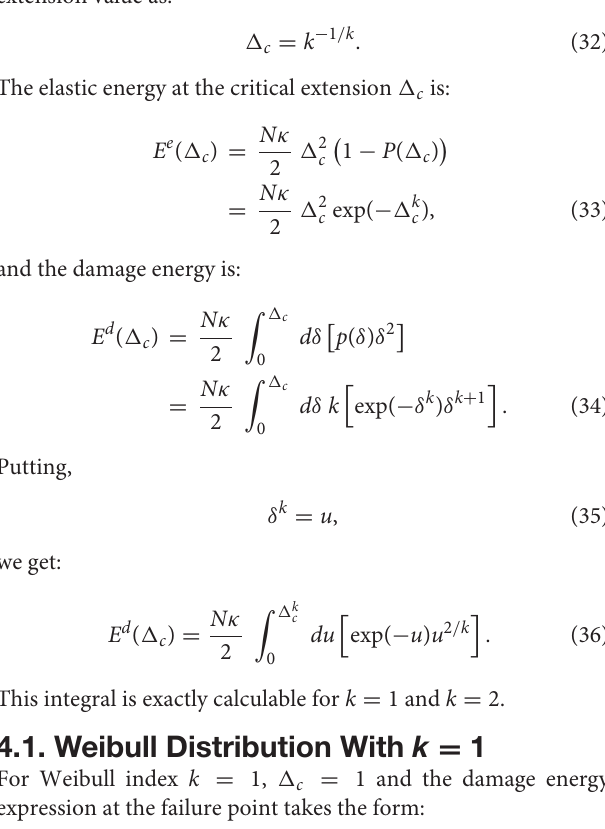
FIGURE 5 | Damage energy and elastic energy vs. extension 1 (up to the failure point 1 c ) for Weibull distribution of thresholds with Weibull index k The simulation data (solid lines) are for a single bundle with N